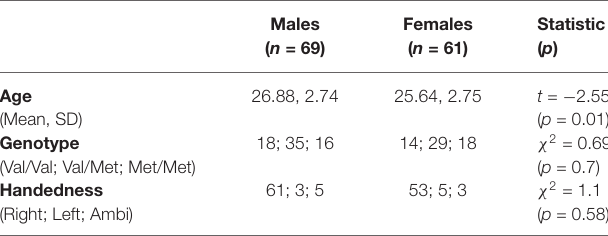
TABLE 1 | Demographic details of experimental participants .